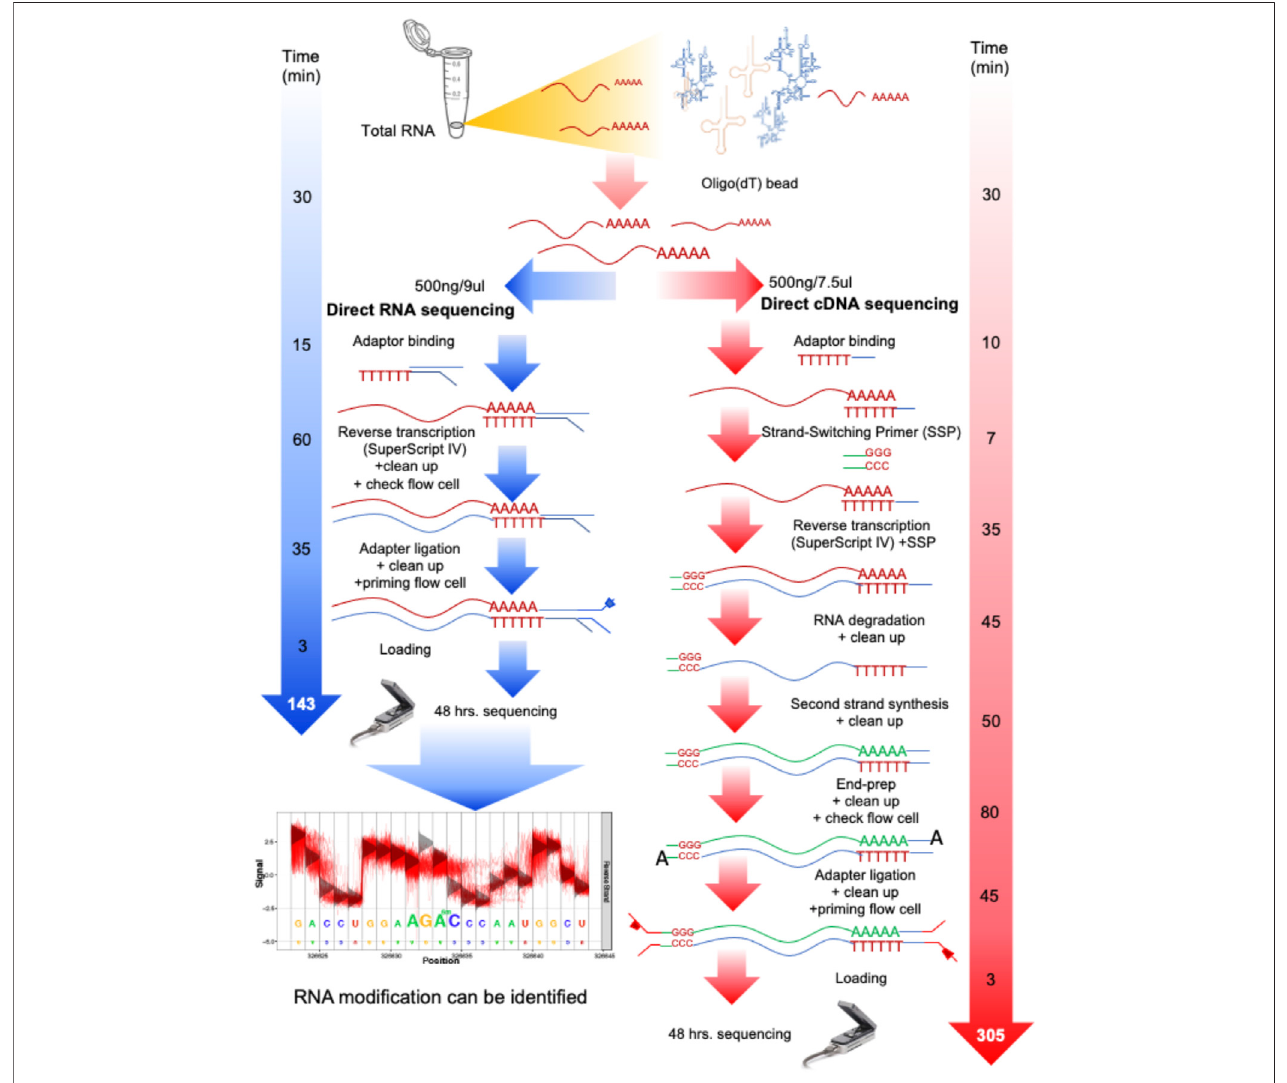
FIGURE 1 | Overall process and time spent on direct RNA sequencing (dRNA-seq) and direct cDNA sequencing (dcDNA-seq) using Oxford Nanopore Technologies(ONT).BothsequencingmethodsareusedtoprepareanyRNAwitha3 ′ poly-Atail,suchaseukaryoticmRNAorviralRNAwithapoly-Atail.ForthedRNA- seq, the native RNA passes through the nanopore, therefore the read length re fl ects the length of the RNA molecules, and the identi fi cation of RNA modi fi cation is allowed. The dcDNA-seq and poly-A RNA were used to prepare cDNA copies for sequencing, which takes more steps and a longer time for library preparation. However, the speed of cDNA sequencing is faster than that of RNA sequencing. Thus, the dcDNA-seq usually provides a higher yield (more bases).